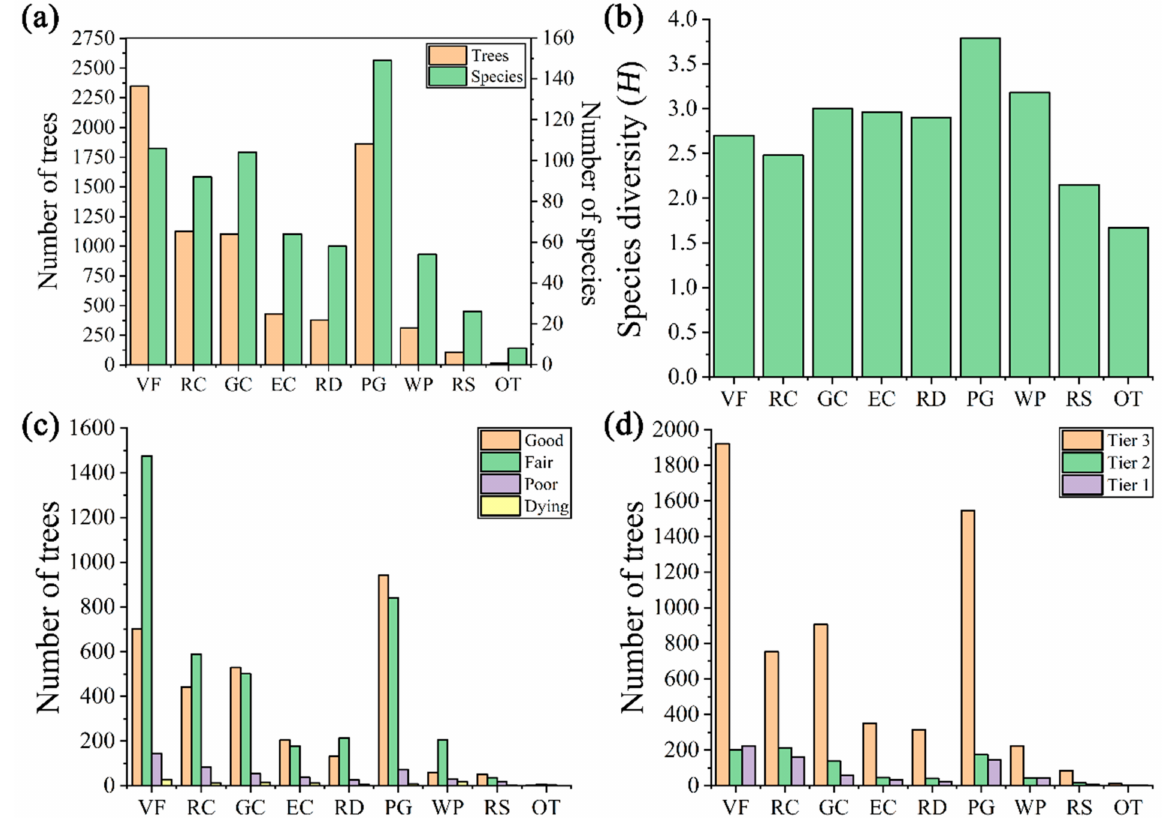
Figure 7. Comparison of spatial distribution by nine tree habitats in Jiangsu Province, eastern China: ( a ) number of trees and species, ( b ) species diversity index, ( c ) abundance by growth status, and ( d ) abundance by tree age. Refer to Table 3 for the meaning of the abbreviated tree